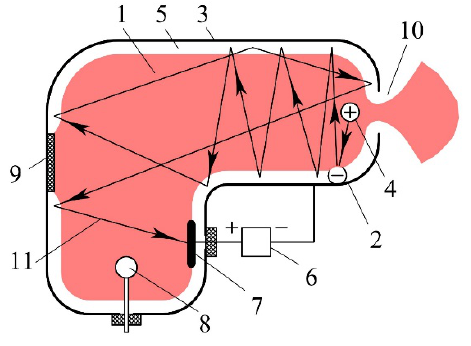
Fig. 5. Electrostatic trap shaped as a hollow cathode.